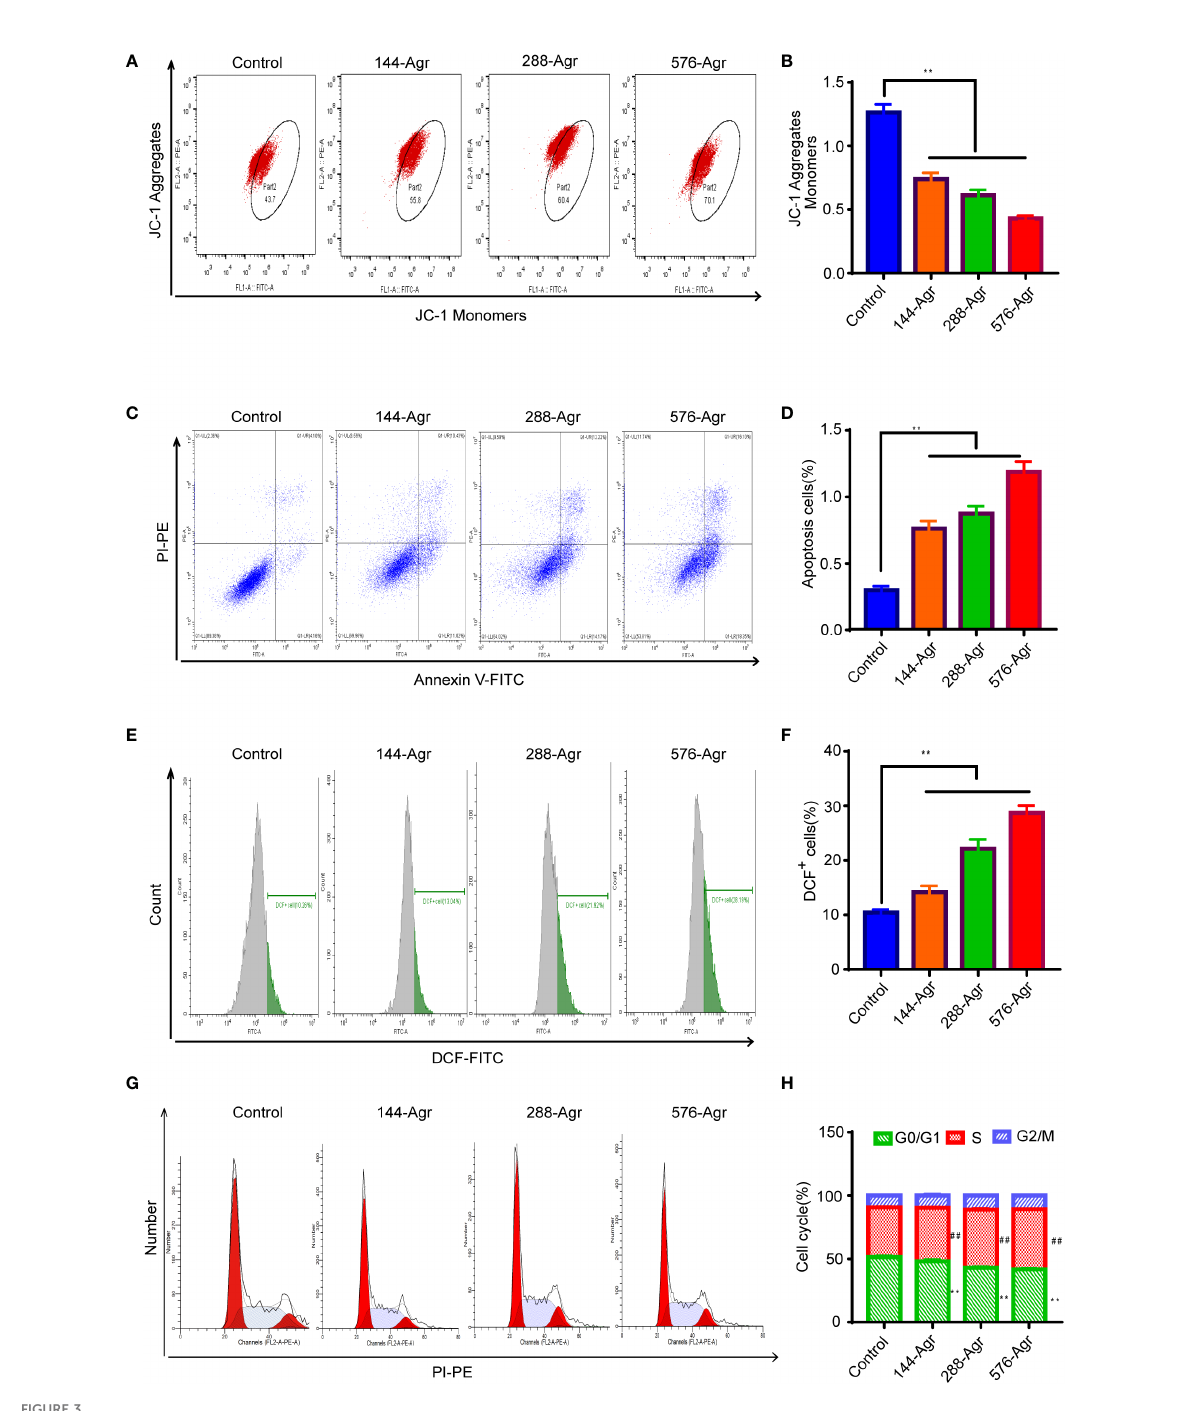
FIGURE 3 Agr induces cell apoptosis of HCT116 cells in vitro . (A) Effects of treatment with Agr on the mitochondrial membrane potential for CRC cells detected by JC-1 staining. (B) The ratio of (JC-1 aggregate)/(JC-1 monomer) fl uorescence intensity shows unusual variations in mitochondrial membrane potential. A decrease in mitochondrial membrane potential indicates an increase in cell apoptosis. (C) After different concentrations (0, 144, 288, and 576 nM) of Agr, HCT116 cell apoptosis was determined by Annexin V – FITC/PI staining. (D) Quantitative data of Annexin V – FITC/PI staining assay; apoptosis of HCT116 cells after treatment with Agr. (E) Effect of Agr on ROS measured via the DCFDA assay for HCT116 cells. (F) Quantitative data of Agr on ROS production in HCT116 cells. (G) Quantitative data from the Annexin V – FITC/PI staining assay; apoptosis of HCT116 cells following treatment with Agr. (H) Cell cycle phase was detected after HCT116 cells were treated with Agr. Red zone (S phase cells), ** p < 0.01 versus control. Green zone (G0/G1 cells), ## p < 0.01 versus control. Agr, agrimol B; CRC, colorectal cancer;